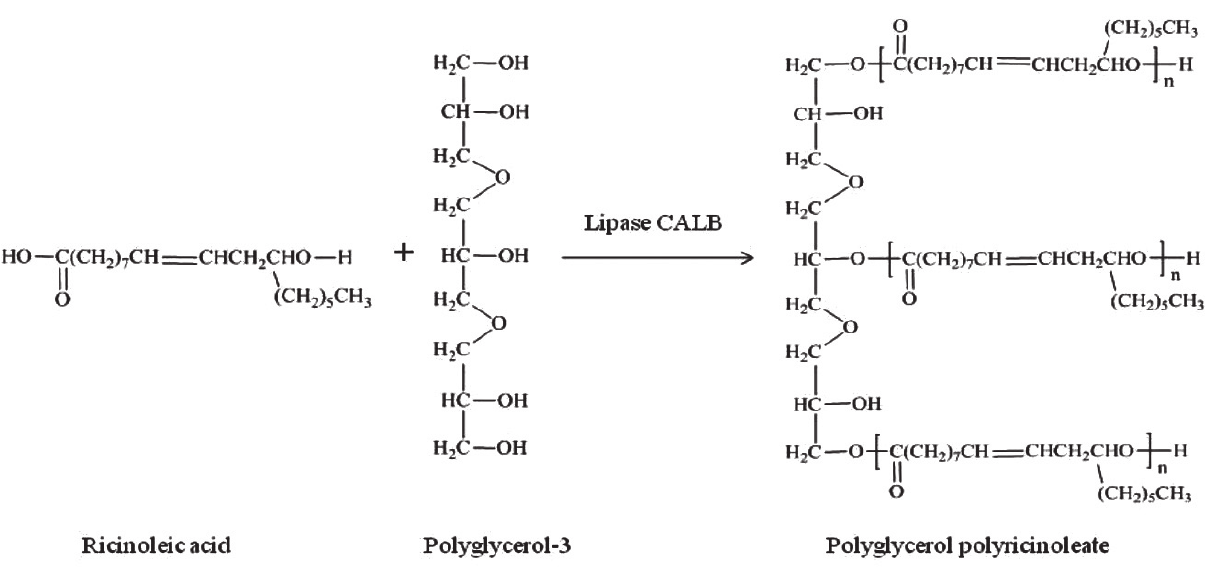
Fig. 1 – PGPR biocatalytic synthesis reaction